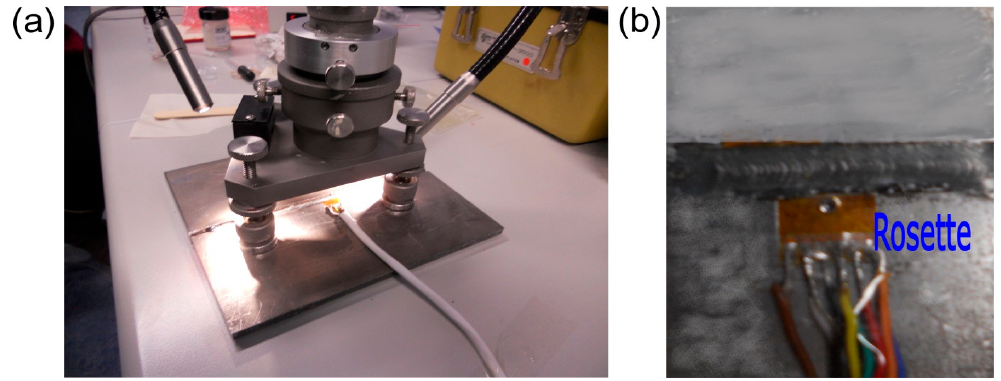
Figure 3. ( a ) RS ‐ 200 milling guide machine. ( b ) Detail of the strain gauge rosette type CEA ‐ 06 ‐ 062UM ‐ 120.